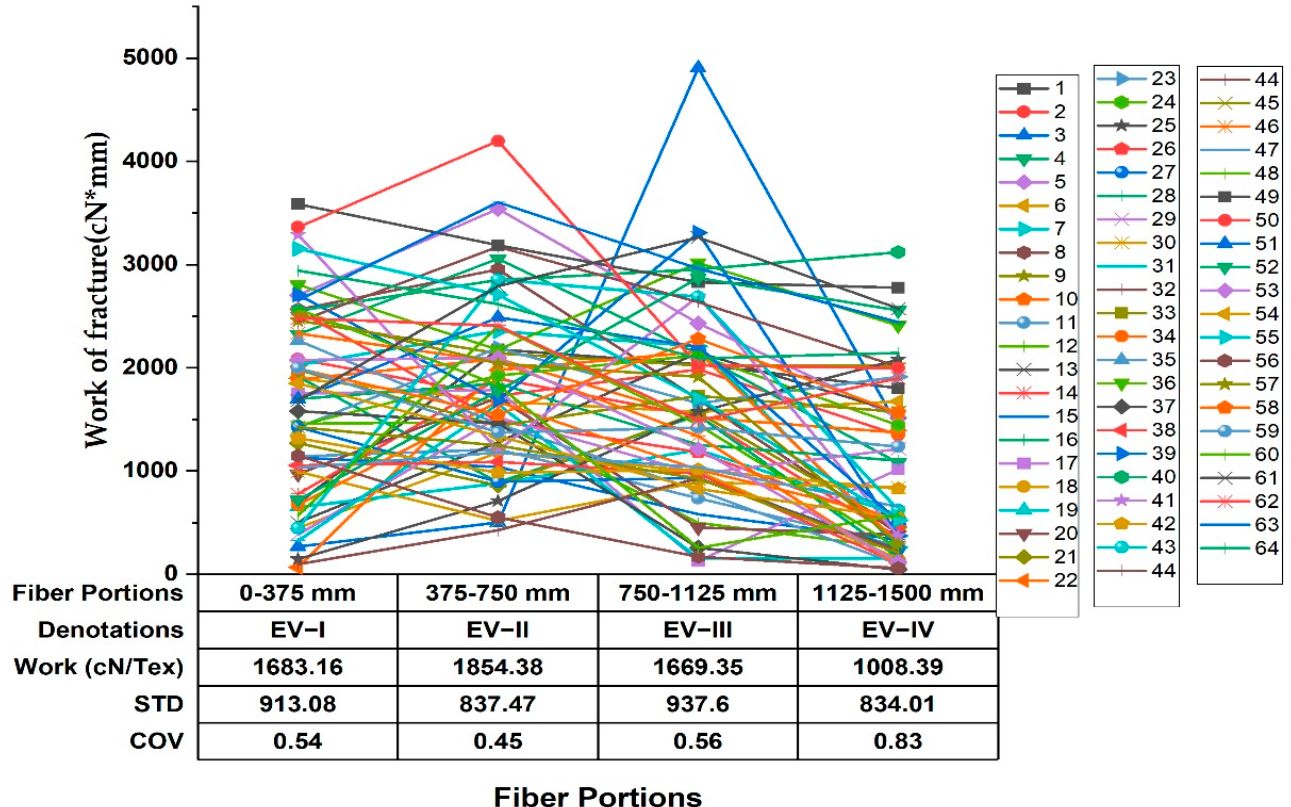
Figure 7. Typical work of rupture of Enset fibers for the fiber sections.